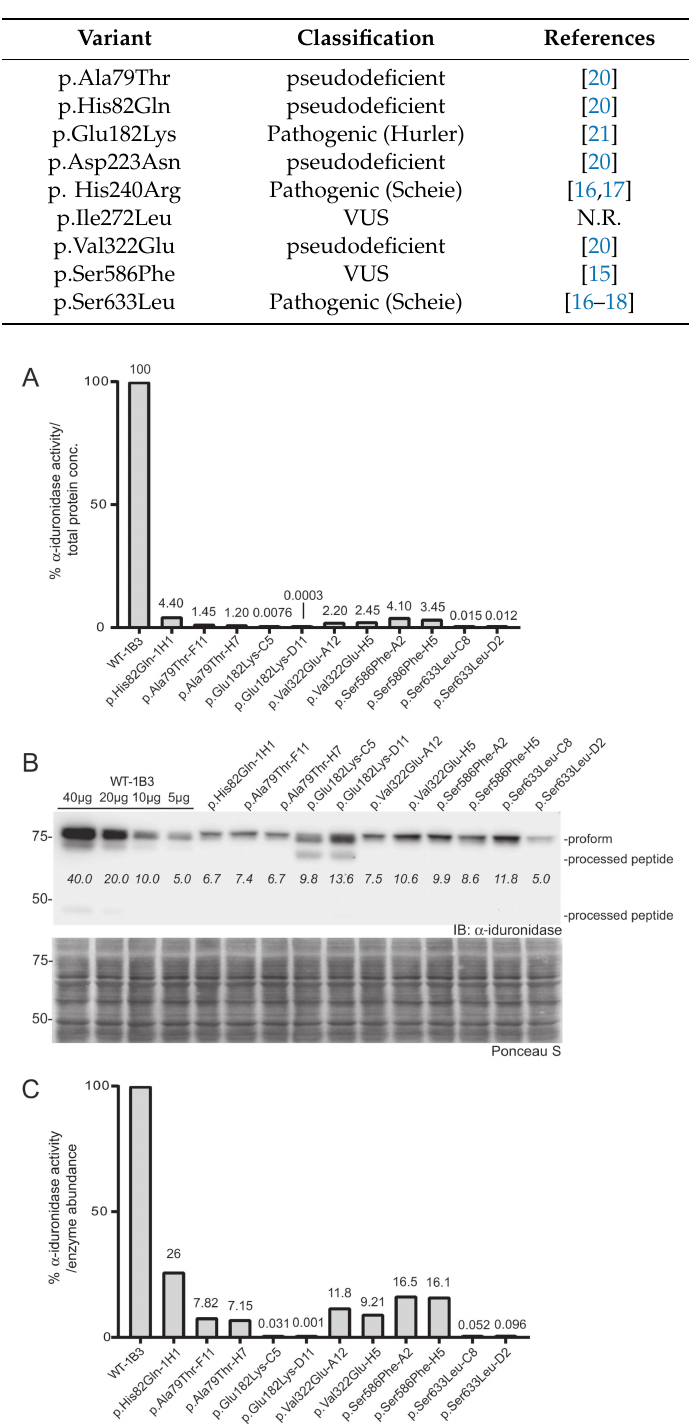
Table 1. List of IDUA variants and their classification within this study.